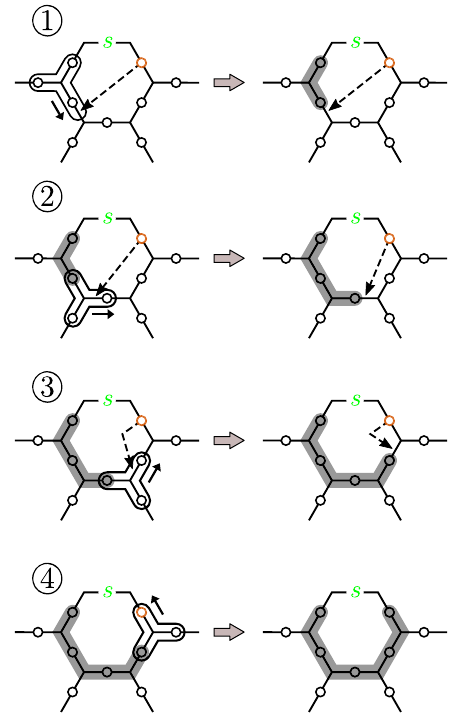
FIG. 16. A circuit decomposition for the C- ˆ B p gate using the labeling convention in Eq. (E1). All the gate operations are controlled by the qudit on the top bond (the green s ). The dashed arrows show the virtual location of the ancillary qudit state, which is stored in the initially disentangled qudit (orange) throughout the steps. In step 1, the qudit gate is a qudit CNOT fol- lowed by Fig. 14(a). The CNOT aligns the | 0 (cid:3) qudit (orange) with the qudit at the endpoint of the string operator that is to be ini- tialized. In steps 2 and 3, the qudit gate is the same as Fig. 14(b), followed by a SWAP gate that keeps the ancillary qudit state in the orange qudit. Step 4 is similar to steps 2 and 3, except that we adapt the circuit slightly, since no ancillary qudit is required at the last step. The explicit circuit diagrams are given in Fig.